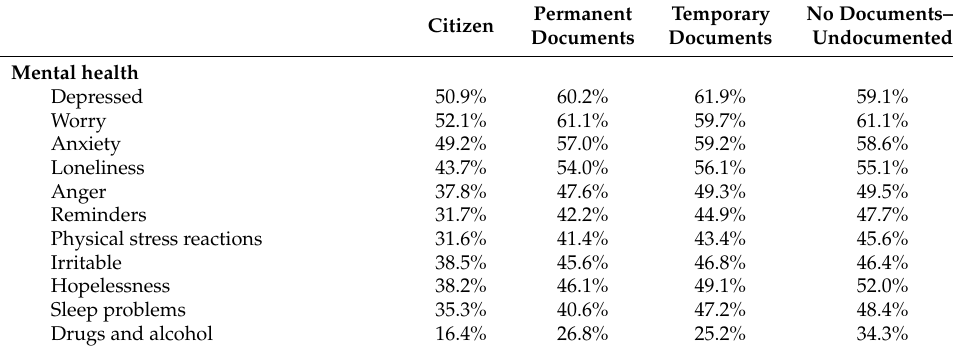
Table 2. Percentage of respondent reporting a deterioration in their condition in relation to resi- dence